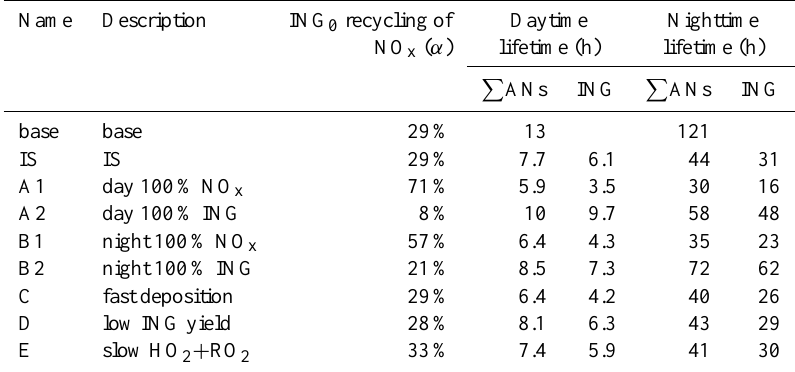
Table 2. NO x recycling efficiency and isoprene nitrates lifetime from the base case, IS scheme, and its sensitivity simulations. The isoprene nitrates (ING) are a subset of the alkyl and multifunctional nitrates